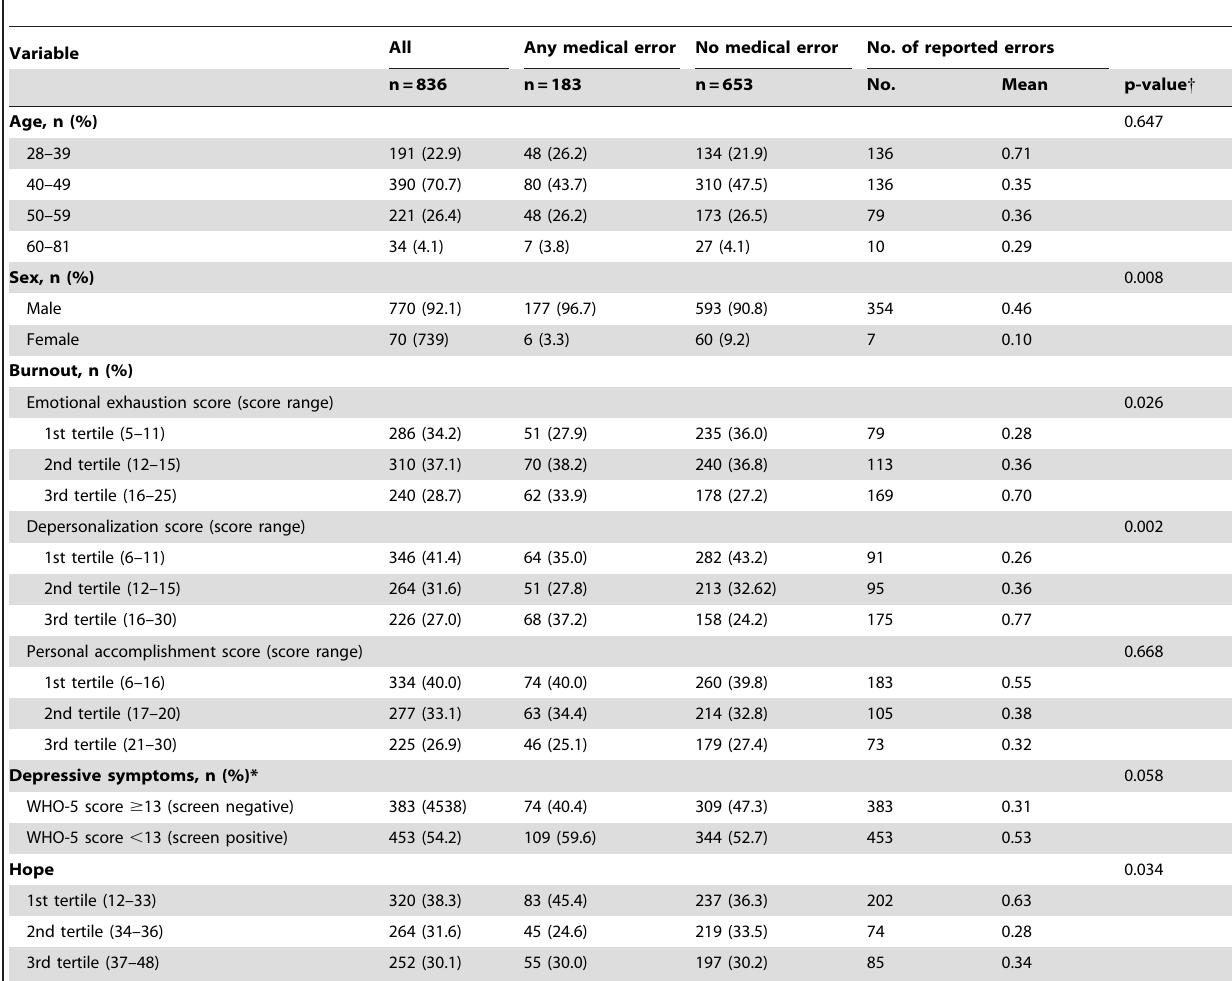
Table 3. Baseline characteristics and medical errors during follow-ups among physicians with and without self-reported medical errors among practicing male and female